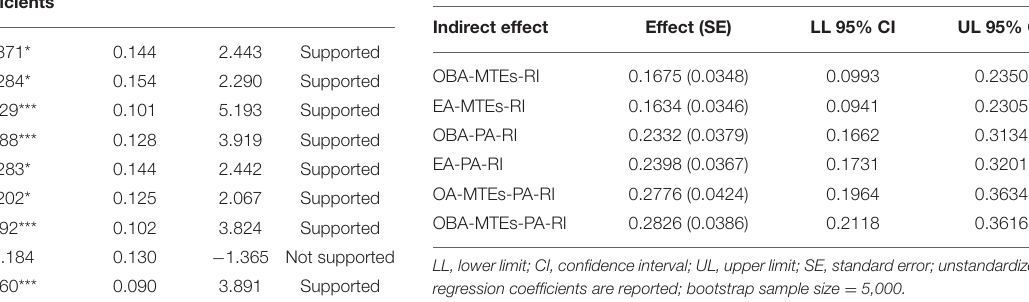
TABLE 5 | Outputs of the bootstrap test of the mediating